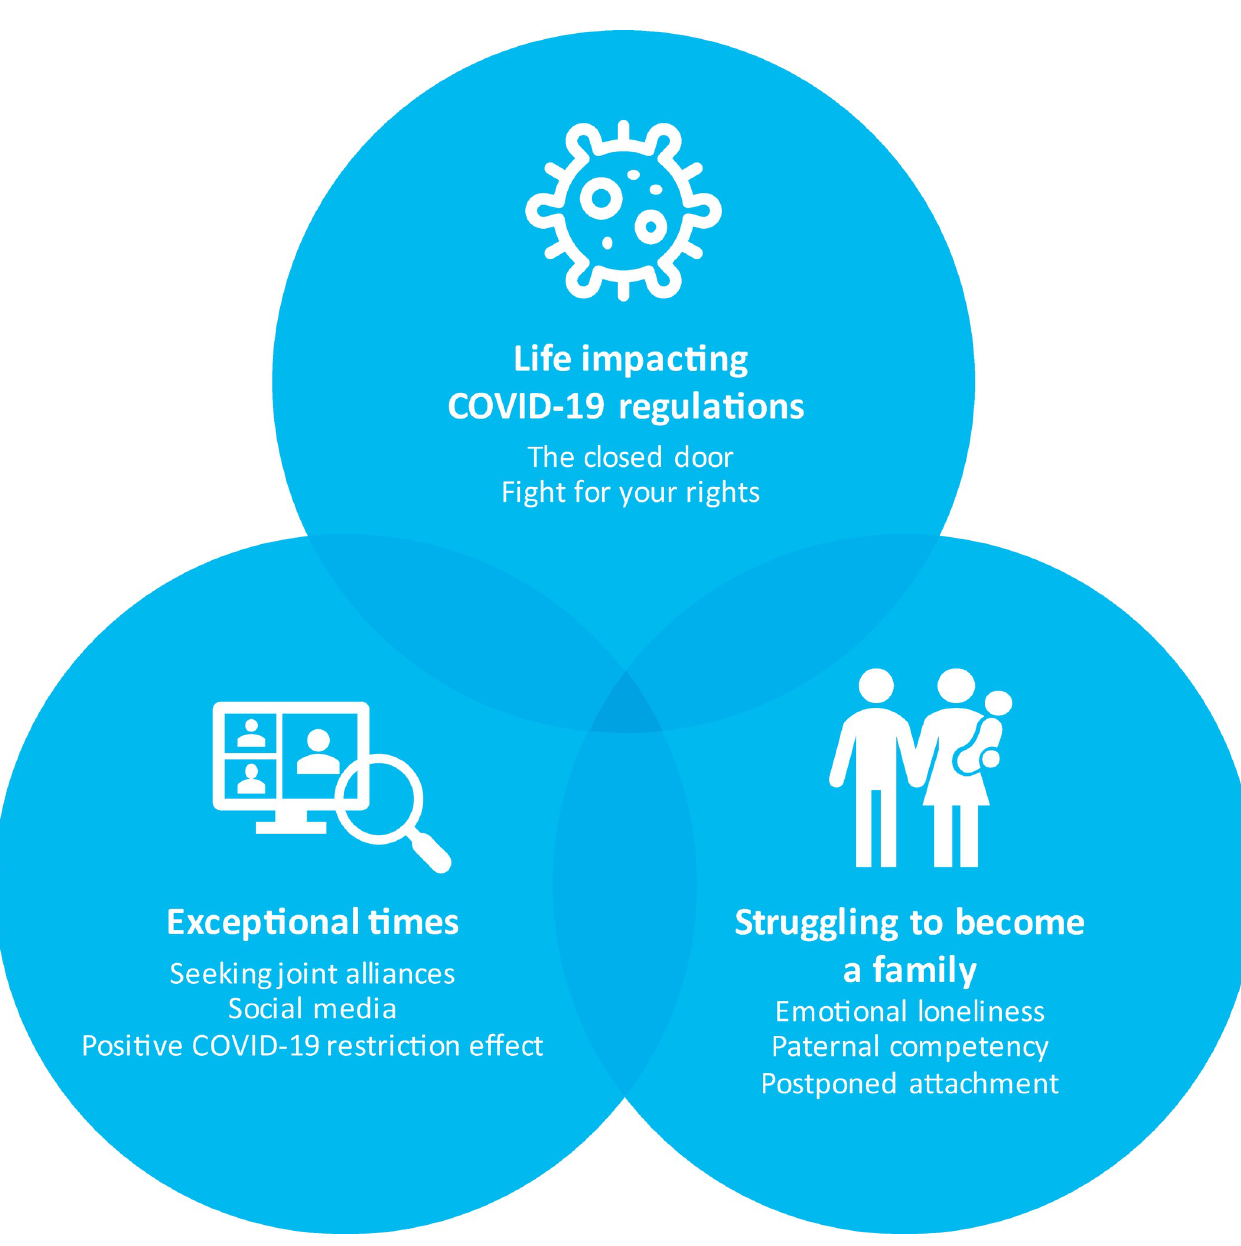
Fig 1. Map with the final overarching themes and the belonging